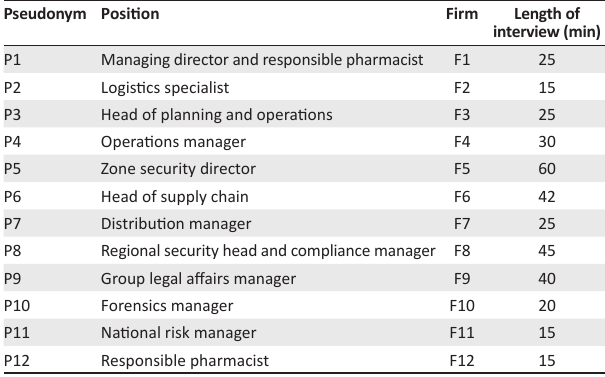
TABLE 1: Profile of the study